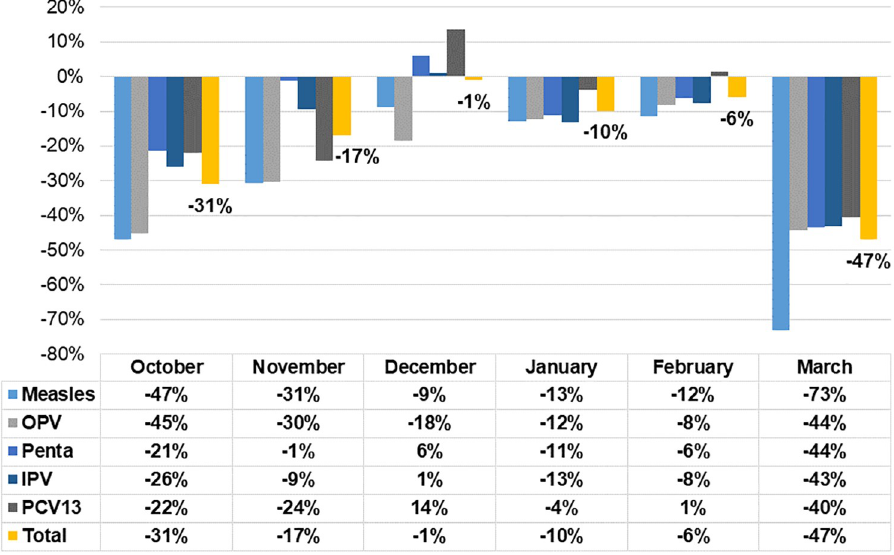
Fig 2. Monthly changes in the number of vaccine doses administered in the public sector as compared to the same period last year.